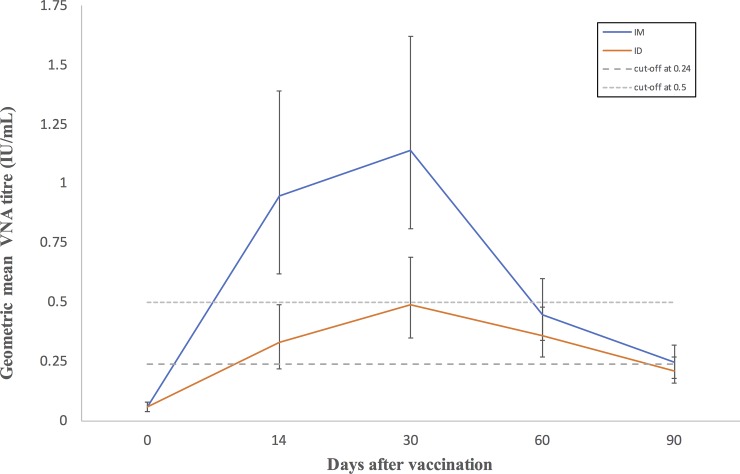
Geometric mean VNA titres of intramuscularly (im) and intradermally (id) vaccinated cattle on 0, 14, 30, 60 and 90 days post vaccination.The error bars indicate 95% confidence interval.